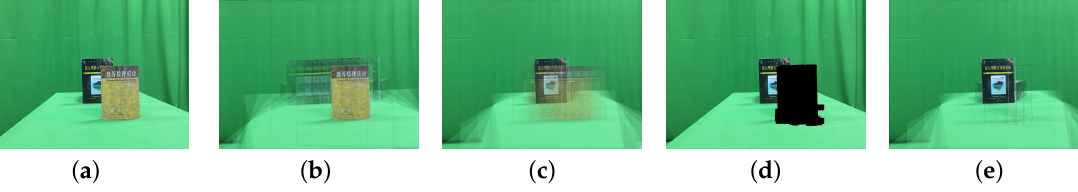
Figure 2. Two books in this scene. ( a ) Reference view. ( b ) Synthetic aperture imaging focused on the front book. ( c ) Synthetic aperture imaging focused on the book behind with the blurry book region. ( d ) Result of removing occlusion via pixel labeling. ( e ) Result of synthetic aperture imaging by removing the front